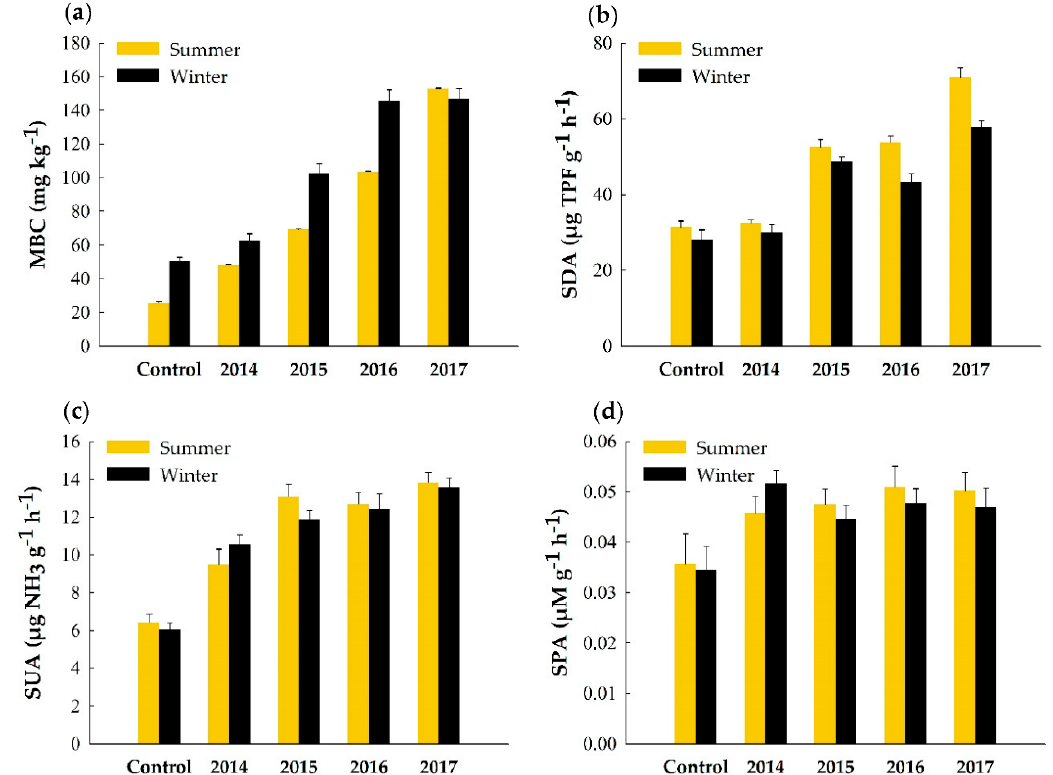
Figure 3. Effect of a D. sissoo plantation on the biological and biochemical properties of the rhizospheric soil samples of Barkachha, Mirzapur, Eastern UP, India, during the four-year study period (2014–2017), in comparison to the soil properties of a control site at the same locality (without plantation) during the year 2014 as a reference/initial value. ( a ) Microbial biomass carbon (MBC), ( b ) Soil dehydrogenase (SDA), ( c ) Soil urease (SUA), and ( d ) Soil peroxidase activity (SPA).